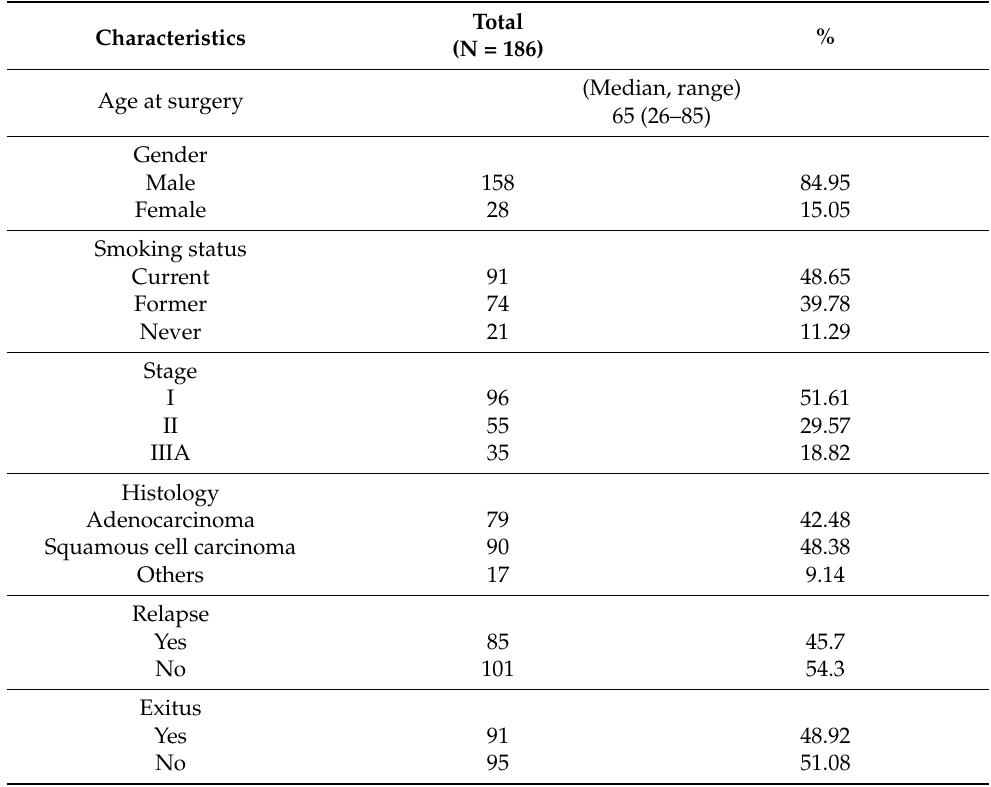
Table 3. Clinicopathological characteristics of the patients included in the HGUV NSCLC cohort.